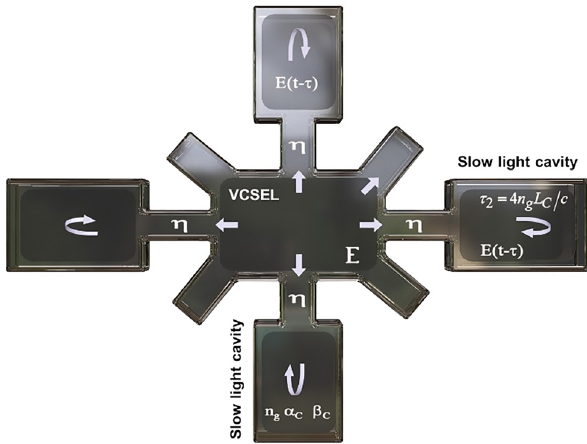
Figure 3: Schematic top-view of VCSEL with each of the multiple surrounding cavities providing direct slow-light